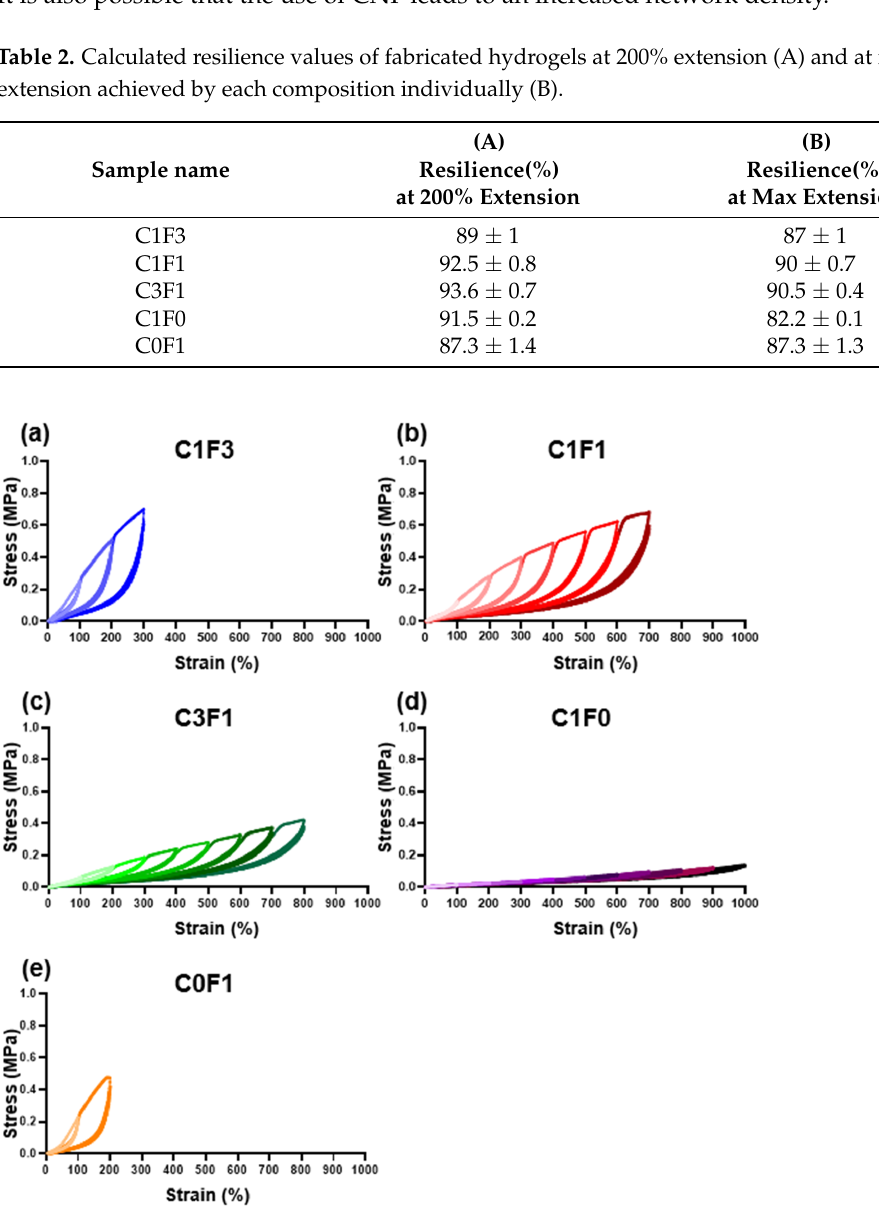
Figure 5. Cyclic tensile loading. Cyclic tensile tests of different fabricated hydrogel samples, namely ( a ) C1F3, ( b ) C1F1, ( c ) C3F1, ( d ) C1F0, and ( e ) C0F1, with CNC and CNF in variable compositions.